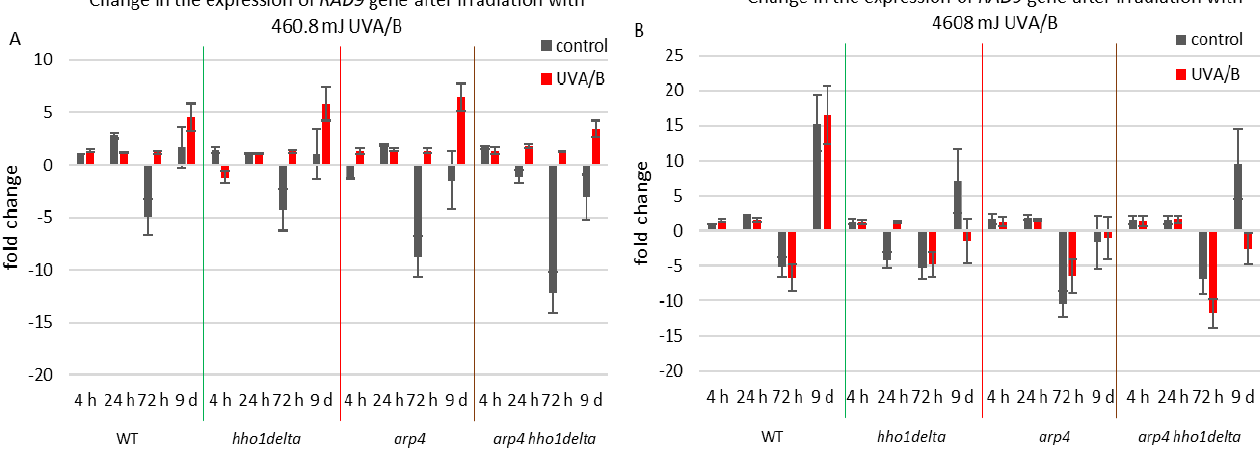
Figure 7. Change in the expression of RAD9 gene after irradiation with 3 min. ( A ) (460.8 mJ). ( B ) 30 min (4608 mJ). Three repetitions of the experiment were performed and results are MEAN fold change ± STDV.